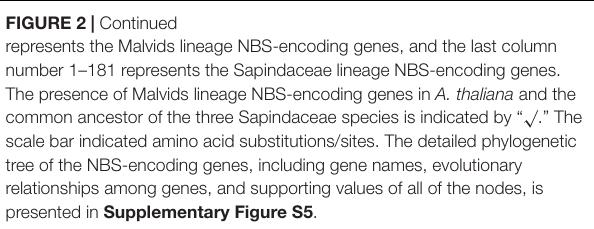
TABLE 2 | Organization of NBS-encoding genes in the three Sapindaceae